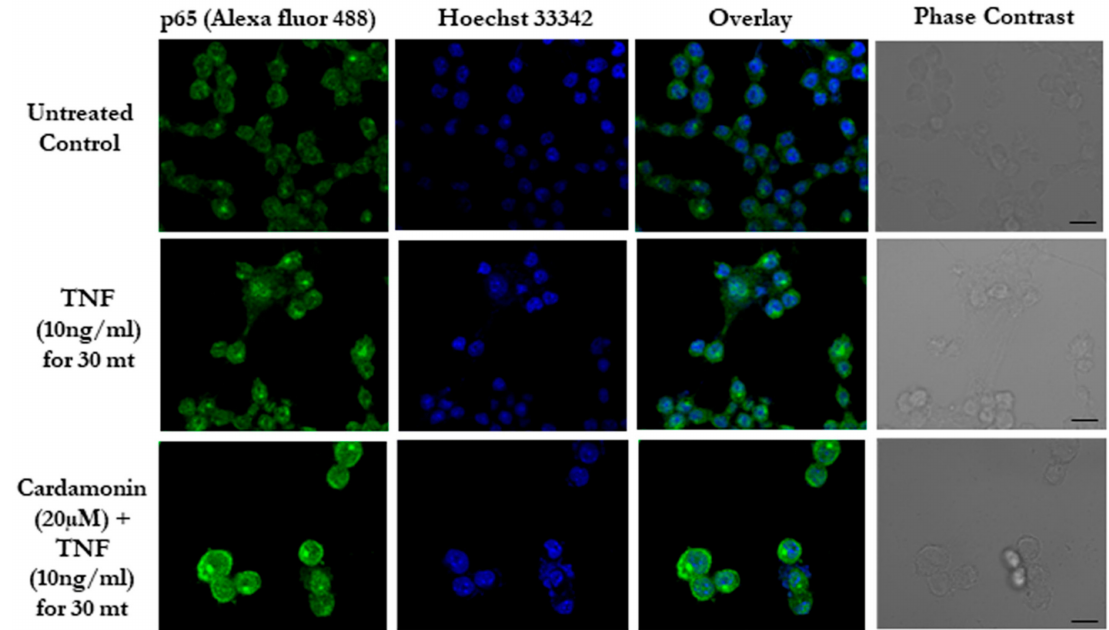
Figure 2. Cardamonin inhibits NF- κ B signaling in vitro. Immunofluorescence of p65 (green) translocation in RAW 264.7 cells after induction with TNF along with pre-treatment with cardamonin. Hoechst (Blue) was used as a counterstain. Scale bar = 20 µ